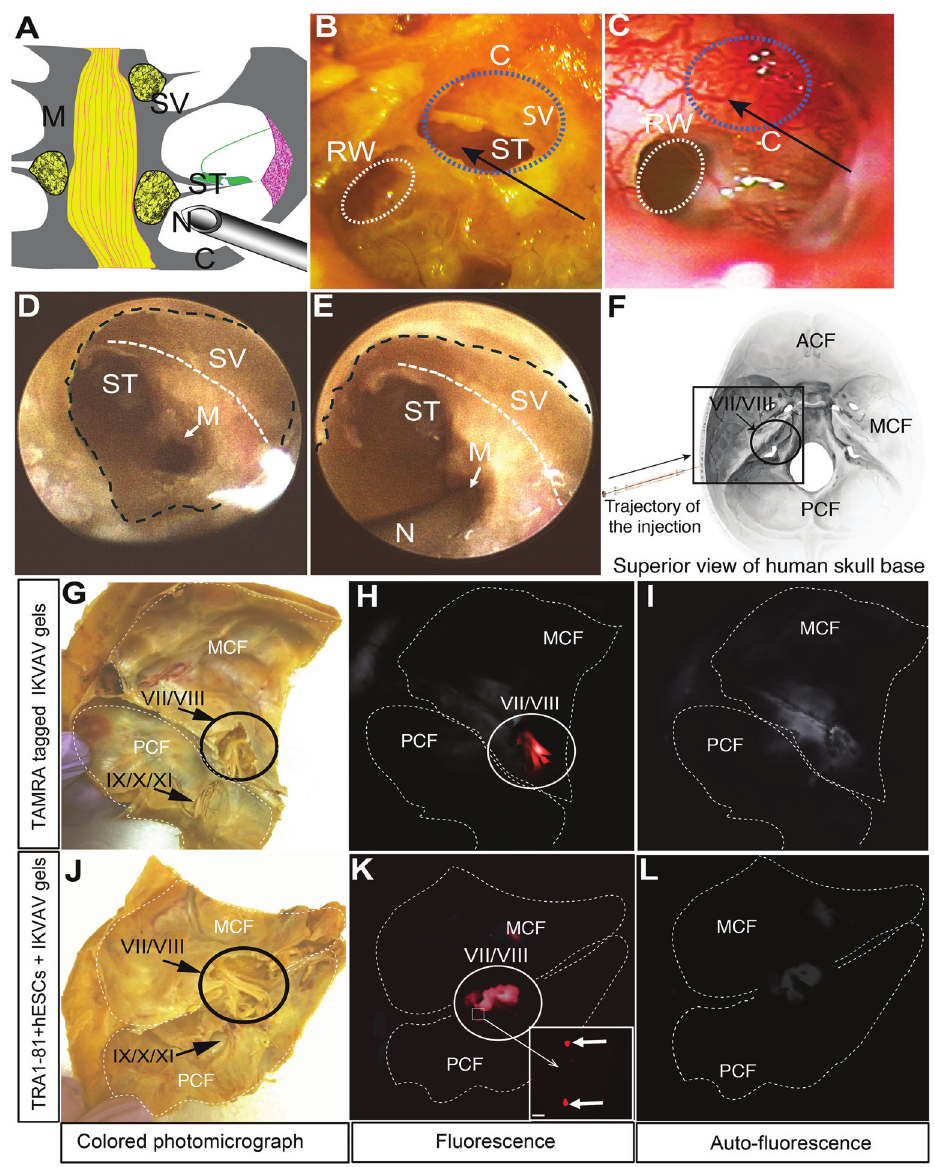
Fig 6. Ex vivo cadaverichuman temporal bone study. (A) : Schematized midmodiolar cross-sectionof a mammalian cochlea,showinginjectionneedleapproaching the modiolus. (B-C) : Photomicrograph of the basal turn of the left cochleain a cadaverictemporal bone (B) and in humans (C) . Black arrows indicate direction of injectionwith IKVAV-PA gels. Note the directionof the fine needlefor injectionof IKVAV gel containing hESCs. A blue-dottedline shows the cochleostomysite. A white dotted line: round window. (D and E) : Endoscopic IKVAV-PA gel injectioninto humanmodiolus.View of cochleostomysite using a 16-mm 0˚ rigid endoscope. A black dashed line marks cochleostomy boundary. A white dashed line indicatespresumed plane of the scala vestibuli. (F) : Artist’s renditionof the superior view of the human skull base, with black arrow showingthe direction of injectionof IKVAV gels with hESCs and anatomical landmarks. Black square corresponds to sectionedarea in subsequent figures. (G-L) : IKVAV-PA gels with hESCs in the IAC in two sets of humancadaverictemporalbones. (G and J) : Middlecranial fossa view of the humancadaverictemporal bone before the hESC injection. TAMRA-tagged IKVAV gels (H) and correspondingautofluorescence measurement observed in normaltemporal bone tissue abuttingthe IAC (I) . TRA-1-81 tagged hESCs with magnifiedinset (K) and correspondingautofluorescencemeasurement (L) . Abbreviations: RW: round window;C: cochleostomy site; ST: scala tympani; SV: scala vestibule;M: modiolus;N: spinalneedle;ACF: anterior cranial fossa; MCF: middle cranial fossa; PCF: posterior cranial fossa. Cranialnerves are denotedby Roman